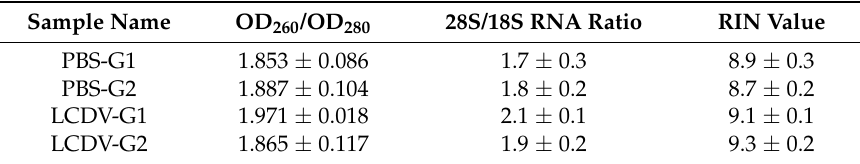
Table 1. The absorbance ratio of RNA OD 260 /OD 280 was less than 1.98 and greater than 1.85, and the brightness of the 28S band was about twice that of the 18S band. RNA integrity number (RIN) was about 9.0 in all samples. Table 1. The detection results of RNA from Agilent